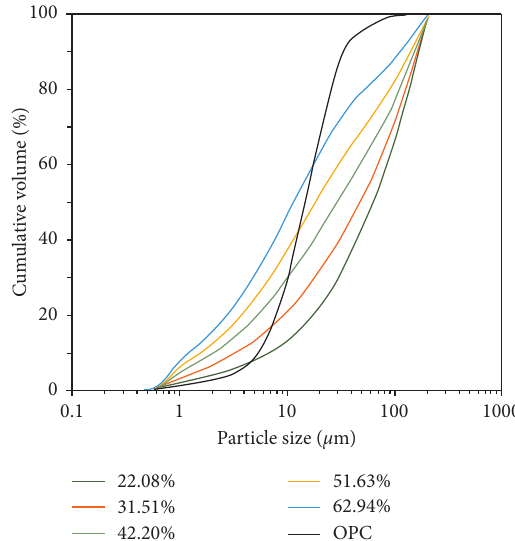
Figure 1: Particle size distribution of tailings and